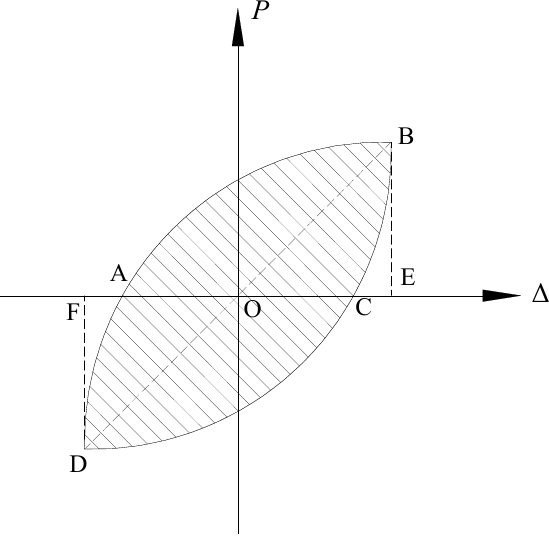
Figure 10. Calculation diagram of the energy dissipation coefficient.